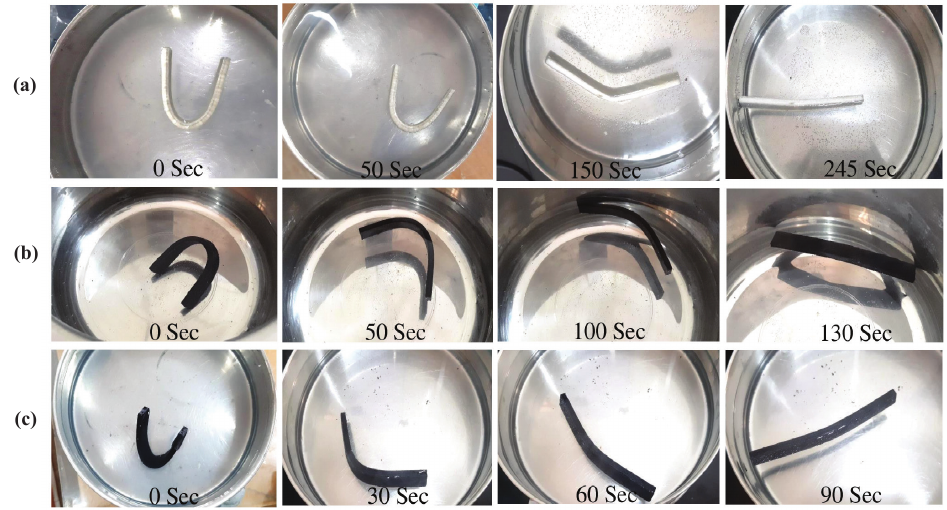
Figure 10. Shape recovery of ( a ) pure SMPU, ( b ) 0.5 wt% MWCNT-reinforced, and ( c ) 1 wt% MWCNT- reinforced specimens at various time frames when placed in the water bath (at 80 ◦ C).